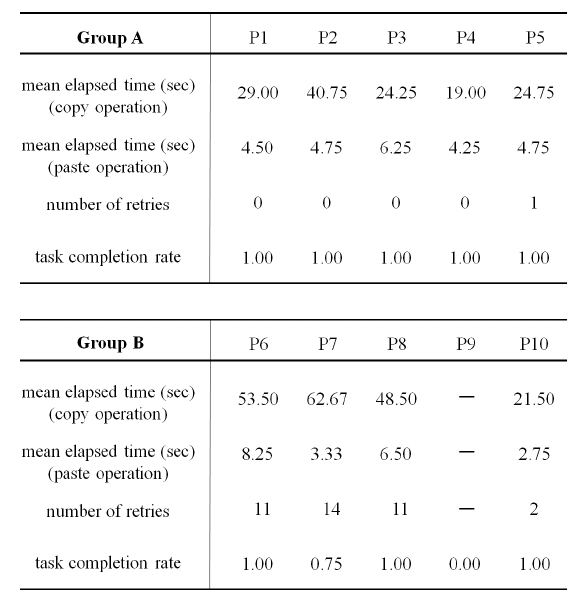
Fig. 12. Experimental results